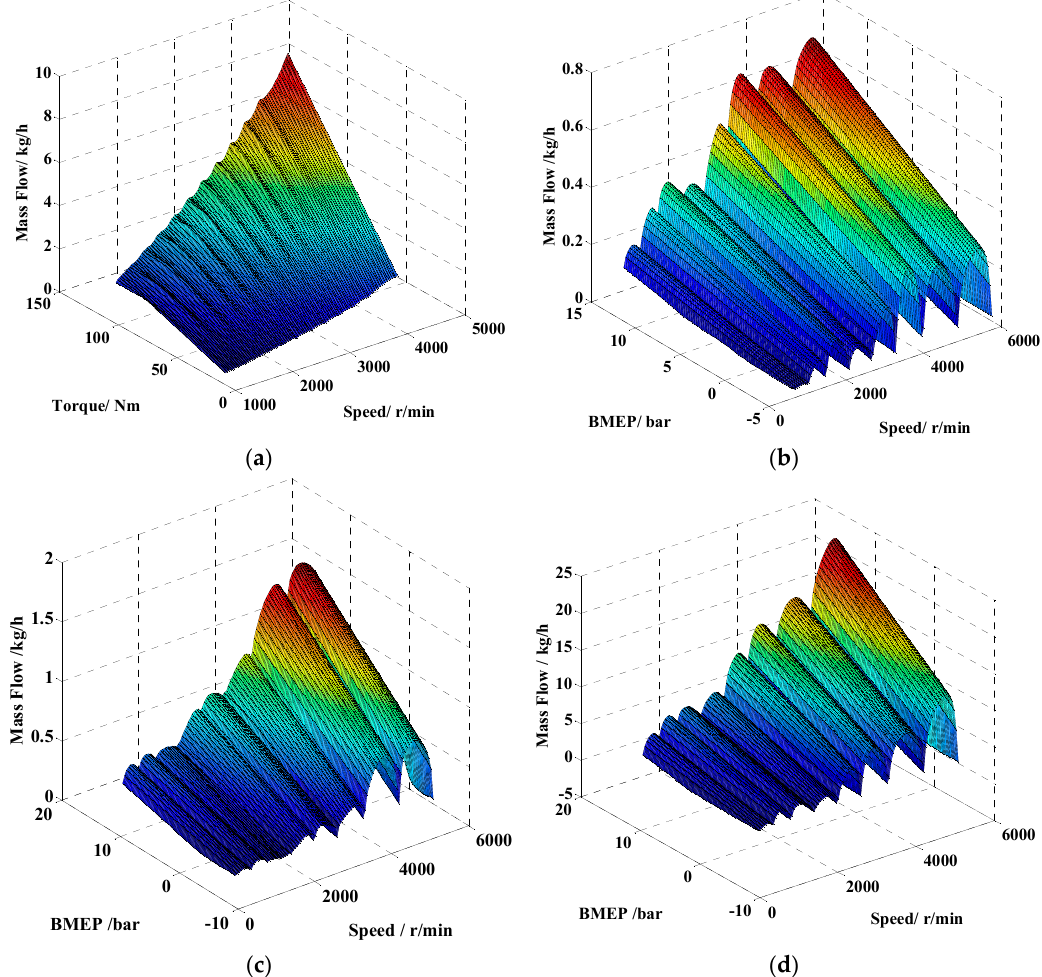
Figure 4. The engine three-dimensional fuel consumption and emission. ( a ) Fuel consumption; ( b ) CO emission; ( c ) HC emission; ( d ) NOx emission.